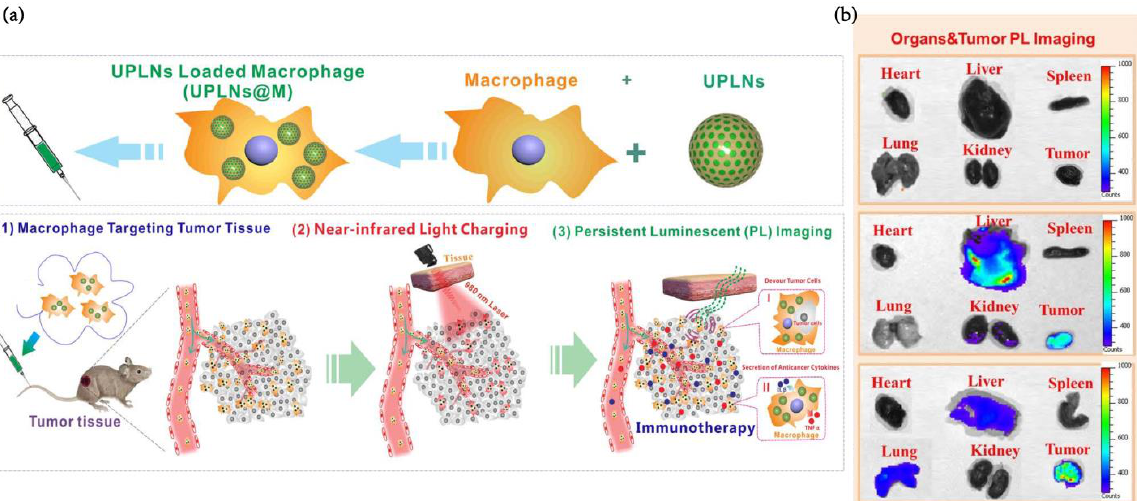
Figure 11. ( a ) Schematic diagram indicating applications of near-infrared (NIR) excitation upcon- verting persistent luminescent nanoparticles (UPLNs)-loading macrophages for real-time tracking of tumor therapeutic macrophages in vivo after endocytosing these nanophosphors in vitro and following macrophage biodistribution by simple whole animal optical detection. ( b ) After tail vein injection for 24 h, the distribution of persistent luminescence nanophosphors in excised organs and tumors for different treatment groups [96]. Reprinted (adapted) with permission from [96]. Copyright 2018, American Chemical